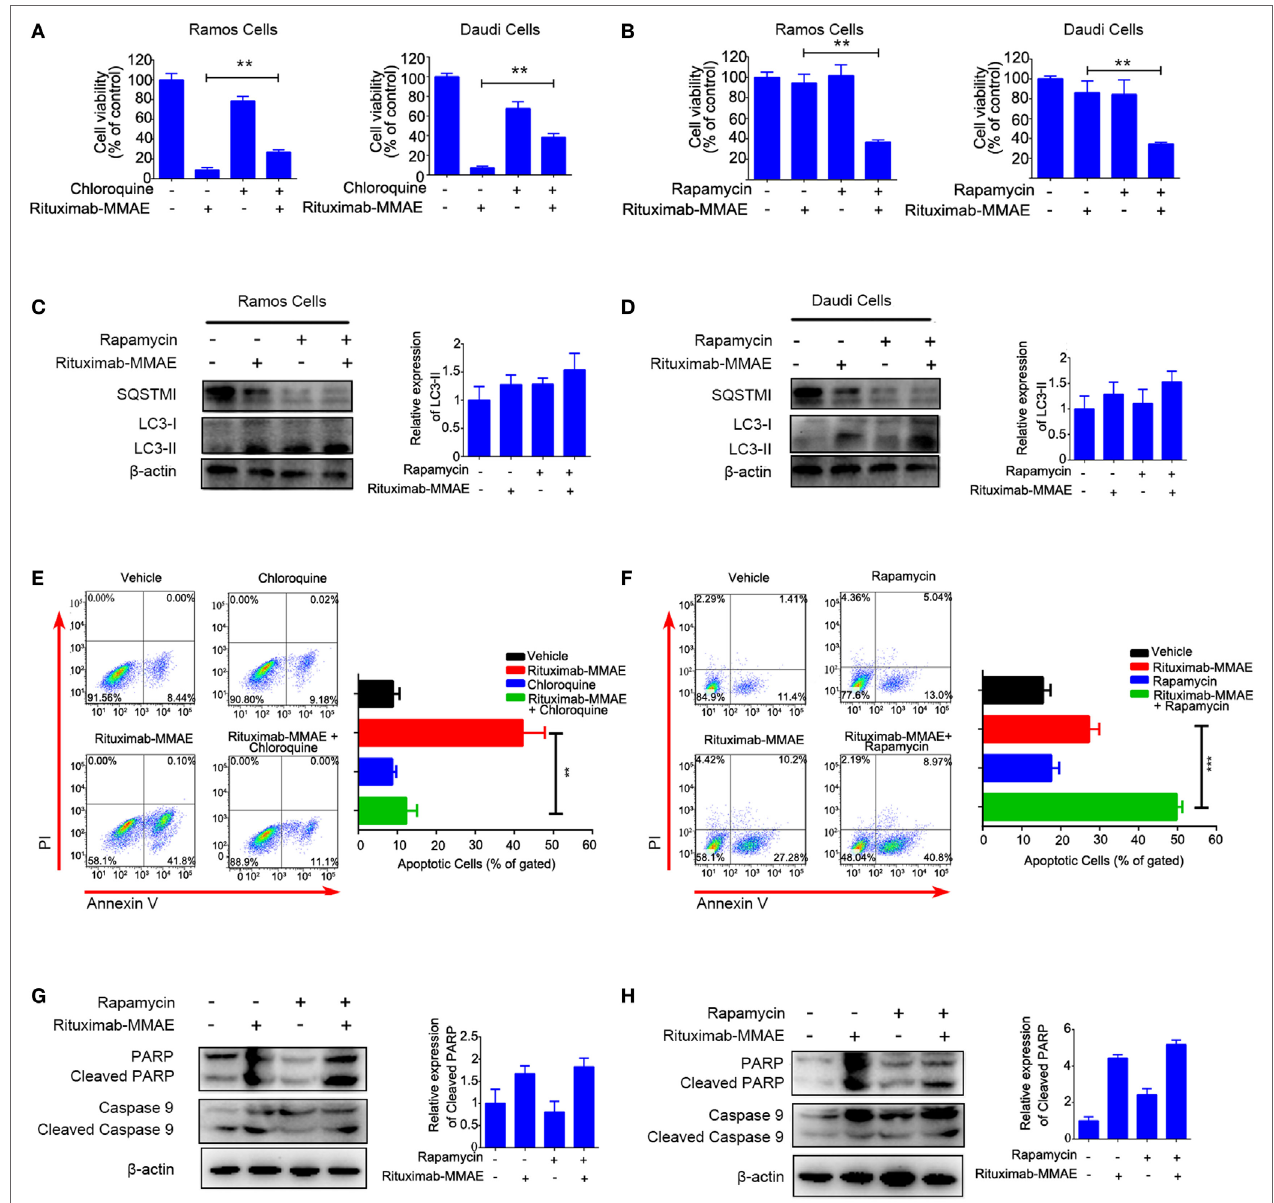
FigUre 5 | Autophagy involved in Rituximab-monomethyl auristatin E (MMAE)-induced cytotoxicity against non-Hodgkin lymphoma cells Ramos and Daudi. (a,B) MTT assay was used to detect cell viability of Ramos cells and Daudi cells treated with Rituximab-MMAE, with or without autophagy activator rapamycin (Rituximab- MMAE 40 ng/mL), or with or without autophagy inhibitor chloroquine (Rituximab-MMAE 160 ng/mL). The data were presented as mean ± SD of three independent experiments (Student’s t -test, * P < 0.05 and ** P < 0.01). (c,D) The protein level of autophagic markers, SQSTM1 and light chain 3 (LC3)-II, were detected by western blot. Densitometric values were quantified by Image J software. (e,F) Apoptosis of Daudi cells treated with Rituximab-MMAE, with or without autophagy activator rapamycin, or with or without autophagy inhibitor chloroquine was detected by Annexin V and PI staining and flow cytometry. The percentage of Annexin V + PI − and Annexin V + PI + cells (apoptosis cells) was shown in the bar chart on right. (g,h) Apoptosis protein, poly ADP-ribose polymerase (PARP), cleaved PARP, caspase 9, and cleaved caspase 9 were detected by western blot. Densitometric values were quantified by Image J